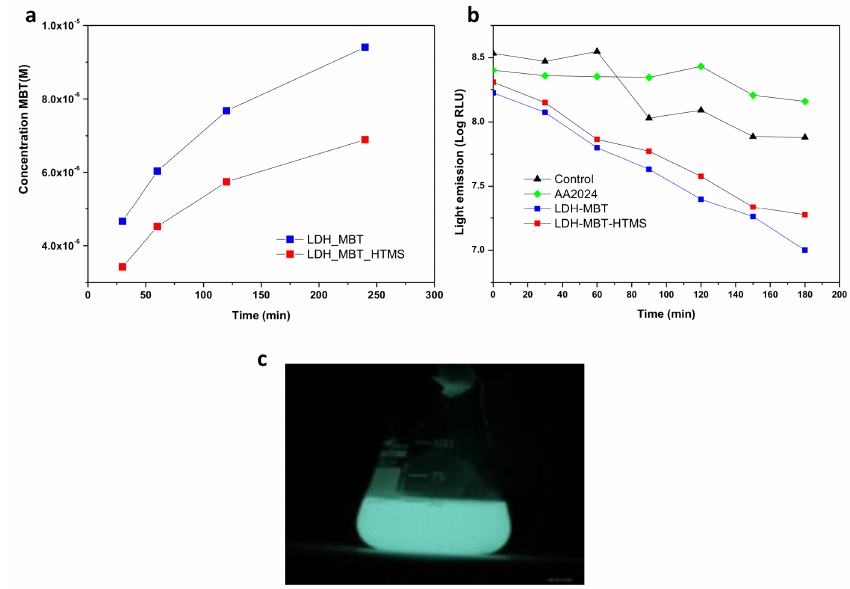
Figure 5. ( a ) Release profile of MBT; ( b ) antibacterial e ff ect observed in the presence of SR-LDH films; ( c ) Escherichia coli bacterial light